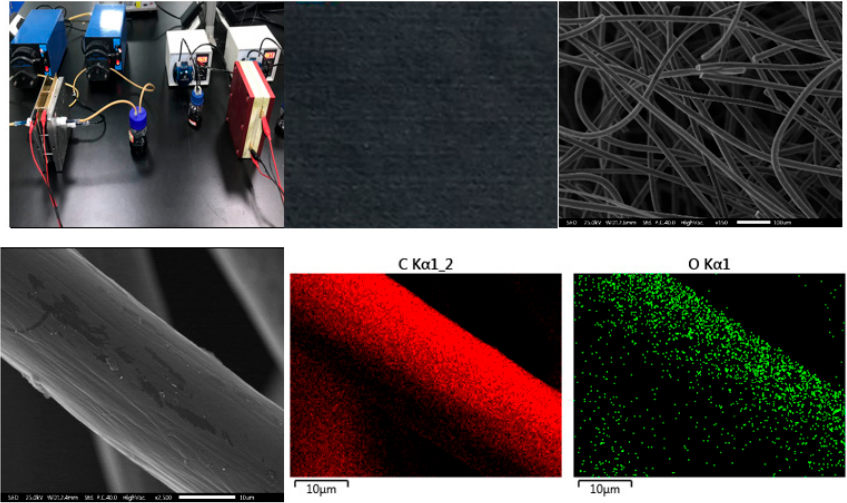
Figure 2. The photographs of VRFB systems and SEM-EDS of the graphite felt electrode.